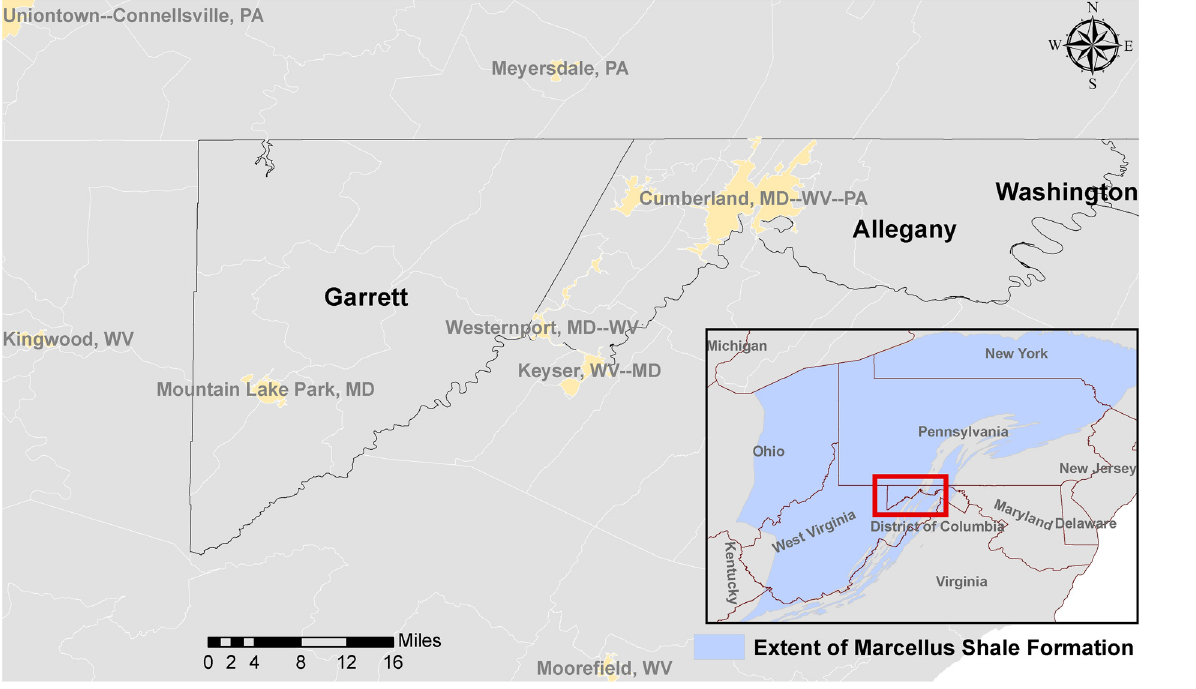
Fig 1. Extent of the Marcellus Shale in Garret and Allegany Counties in Western